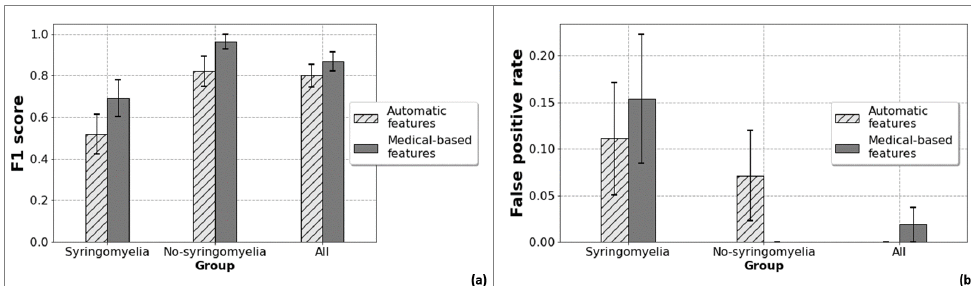
Figure 7. F1-score ( a ) and false positive rate ( b ) of SVM classifier. For both ( a , b ) we can observe from left to right patients with syringomyelia, without syringomyelia and all together. The corresponding side-by-side bars, differentiated by textures and colors, provide the two metrics respectively for the SVM fed with features automatically obtained from our methodology (light gray, dashed bar) and with medical-based features (dark gray, solid). The error bars provide the standard error among the Leave-One-Out cross-validation folds. Both the metrics are “macro-weighted”, namely averaged among the two